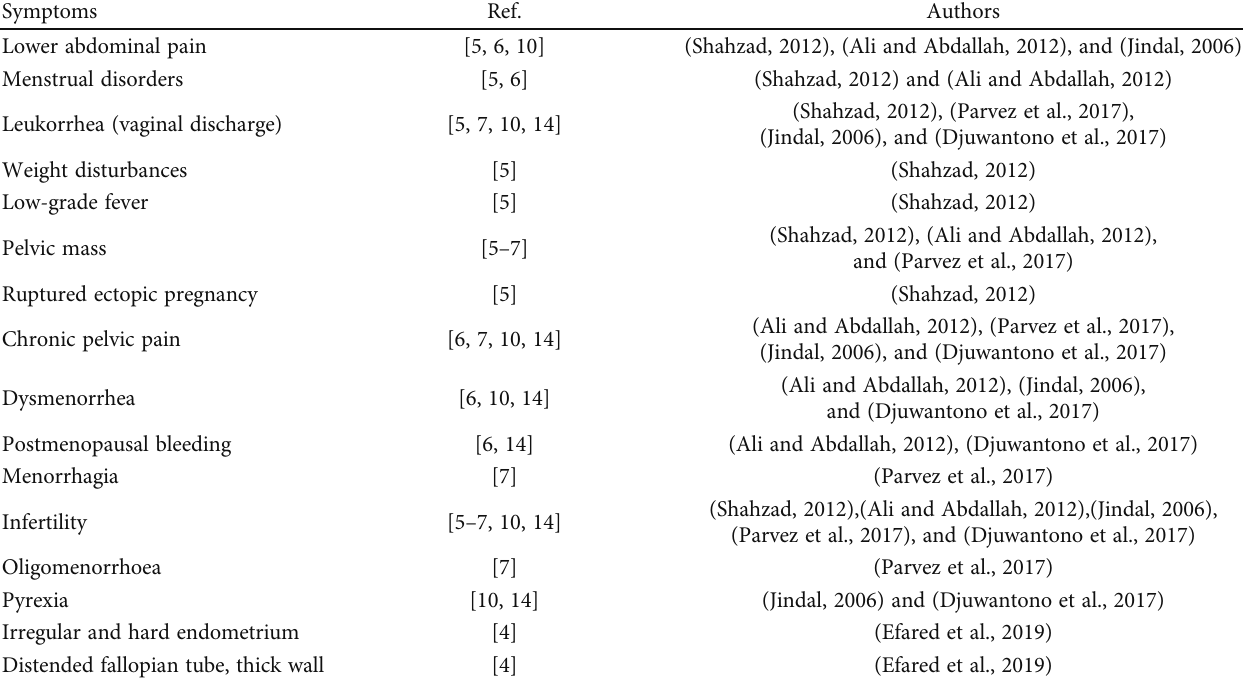
Table 2: Symptoms and signs in